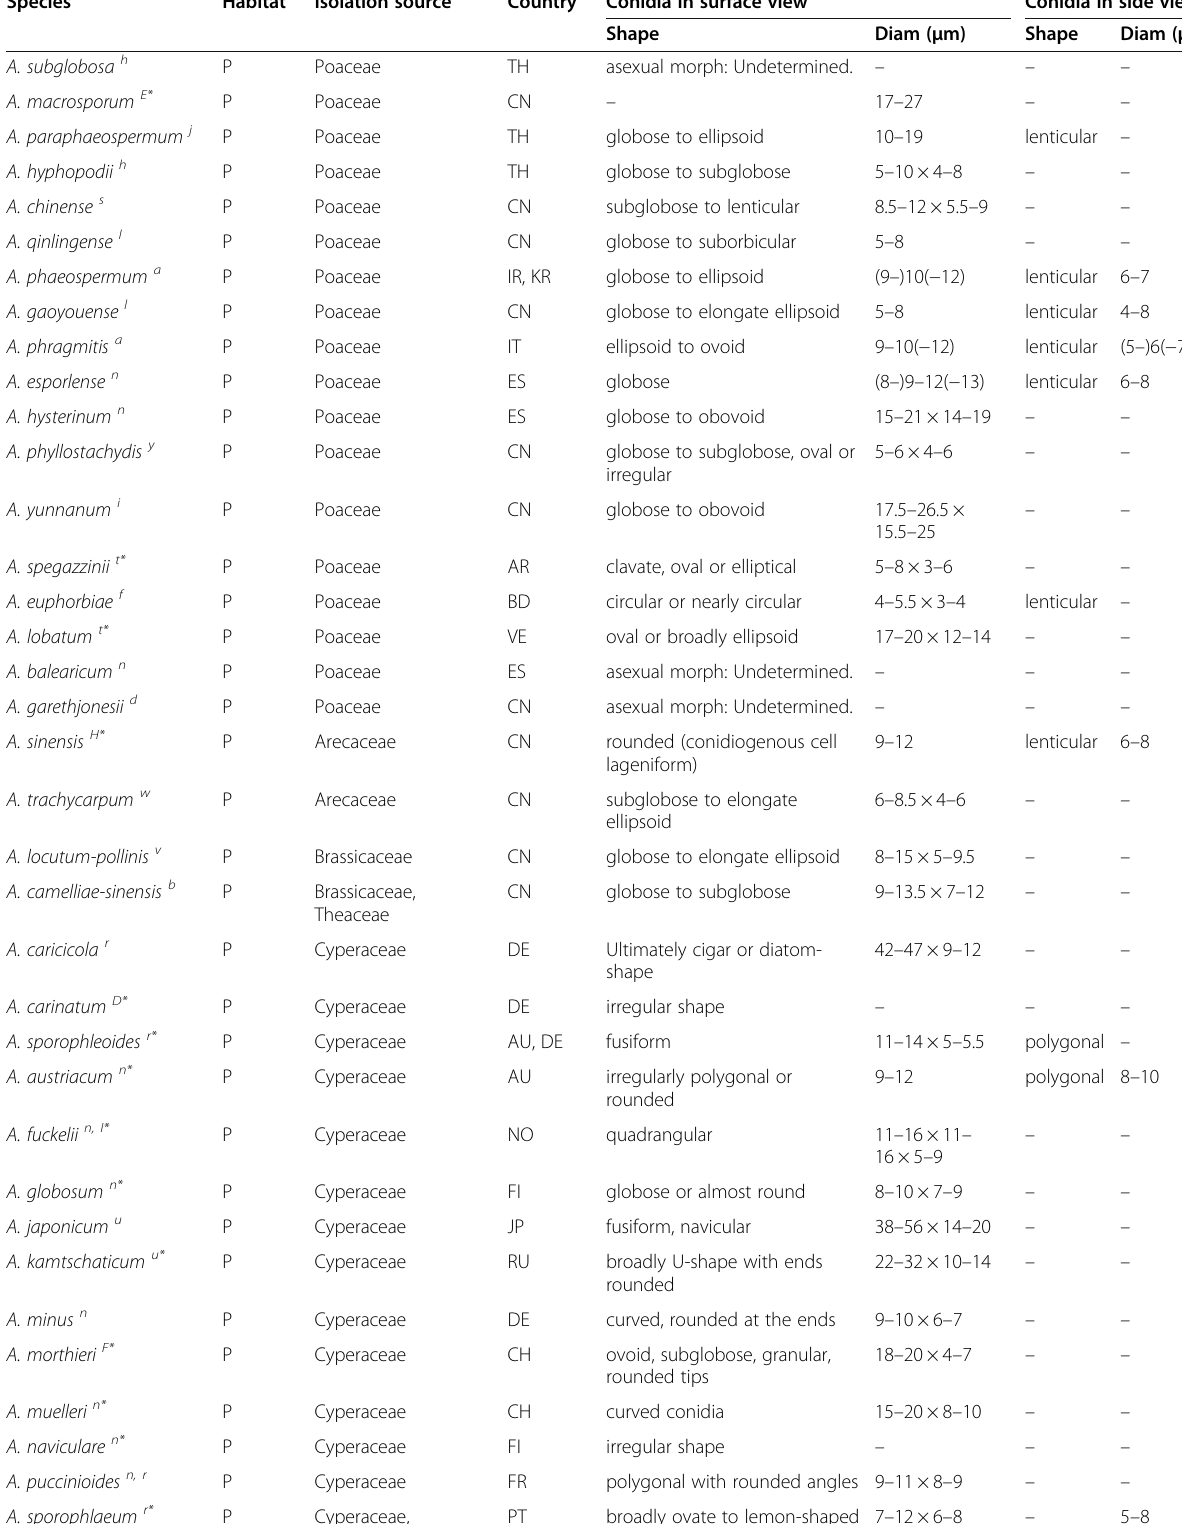
Table 2 Summary of conidial morphology of Arthrinium species. Newly established species in this study are shown in bold